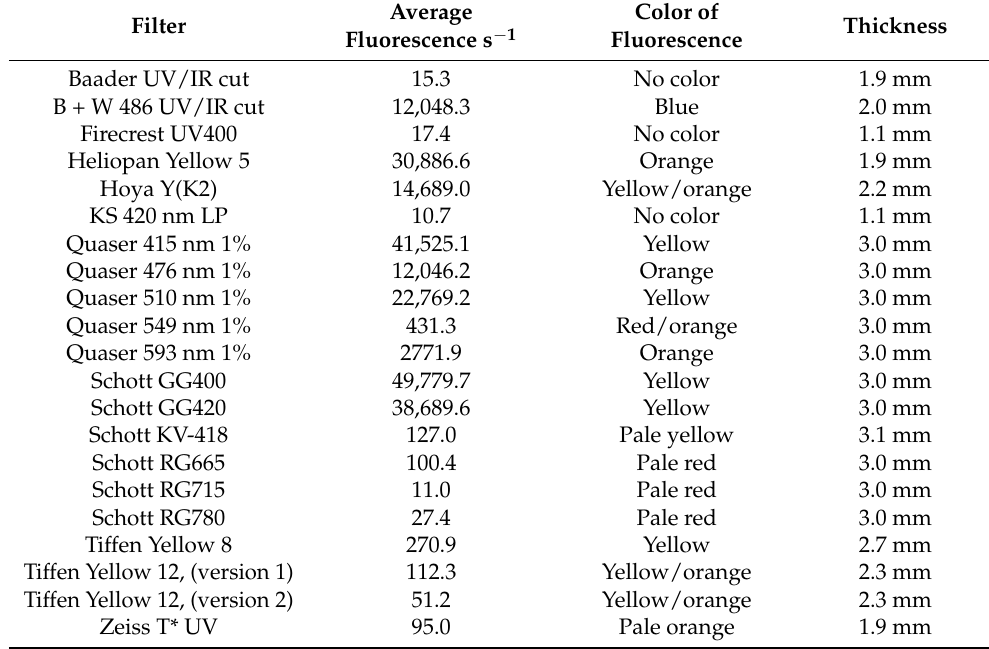
Figure 2. Fluorescence of the test photographic filters normalized to Schott KV-418. Bar color indi- cates the color of the filter fluorescence.